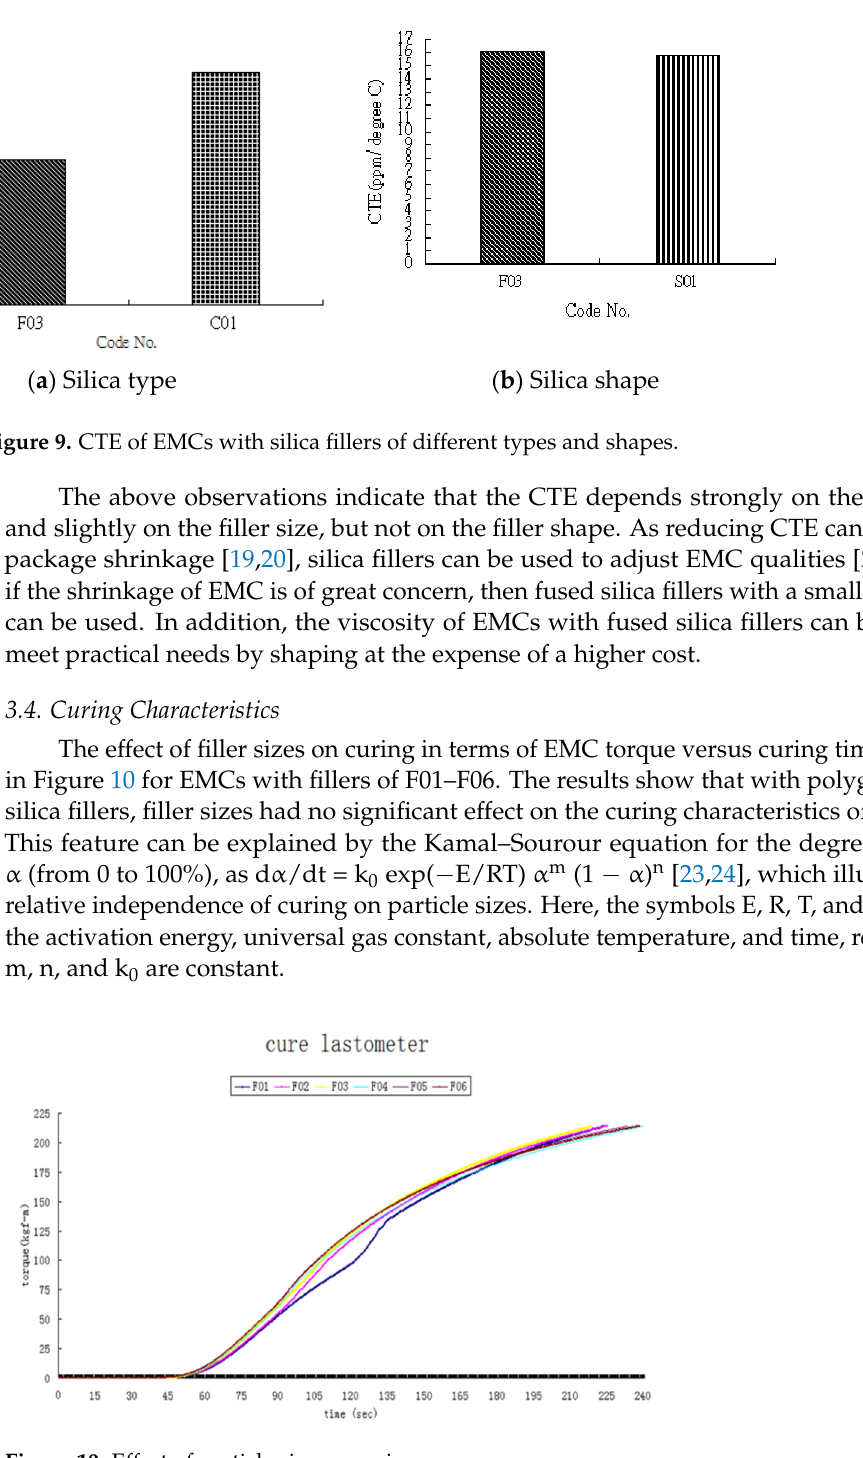
Figure 8. Coefficient of thermal expansion (CTE) versus D50 for polygonal fused silica ( σ : 0.004 ppm/K–0.030 ppm/K).